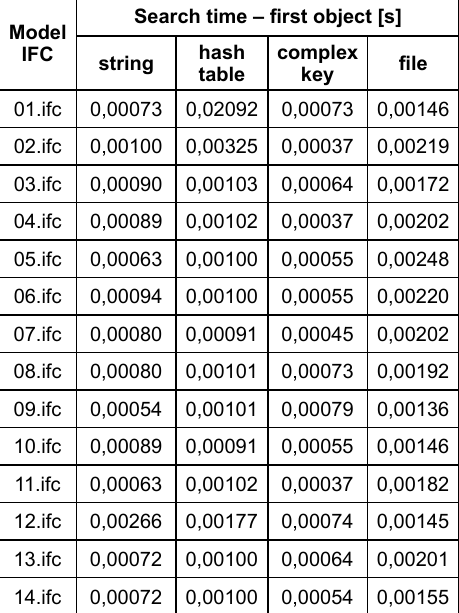
Tab. 9. List of reading times for the first object in test models from the database in each of the three